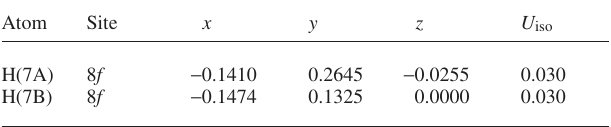
Table 2. Atomic coordinates and displacement parameters (in Å 2 ) .